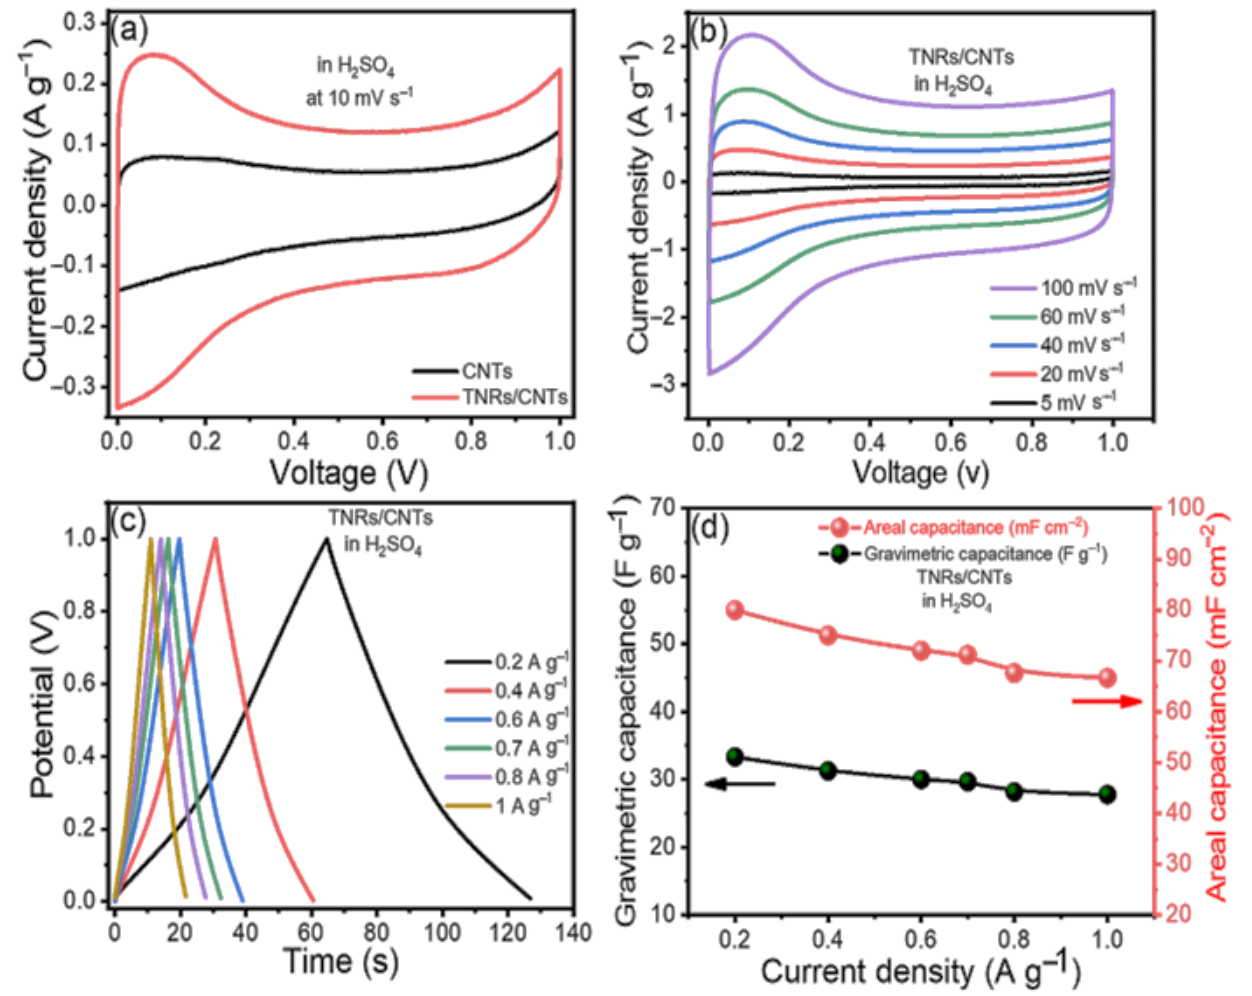
Figure 3. The electrochemical performance of the TNR/CNT electrodes in the H 2 SO 4 ( a ) cyclic voltammograms (CVs) of the CNTs and TNR/CNTs at a scan rate of 10 mV s - 1 , ( b ) CVs at different scan rates, ( c ) charge/discharge curves (CDs) at different current densities, and ( d ) computed gravimetric and areal capacitances at different current densities.